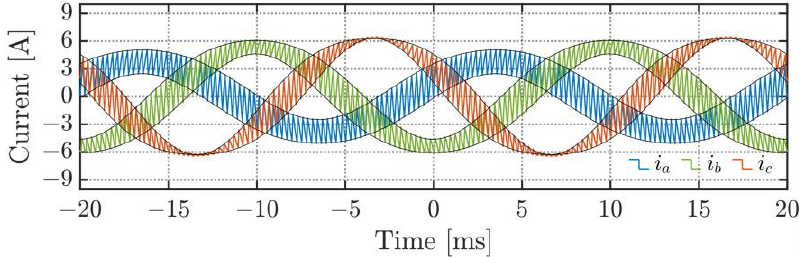
Figure 13. Instantaneous experimental phase currents ( m a = 0.3, m b = 0.4, and m c = 0.5) and their envelopes (black lines) at a switching frequency of 3.6 kHz.